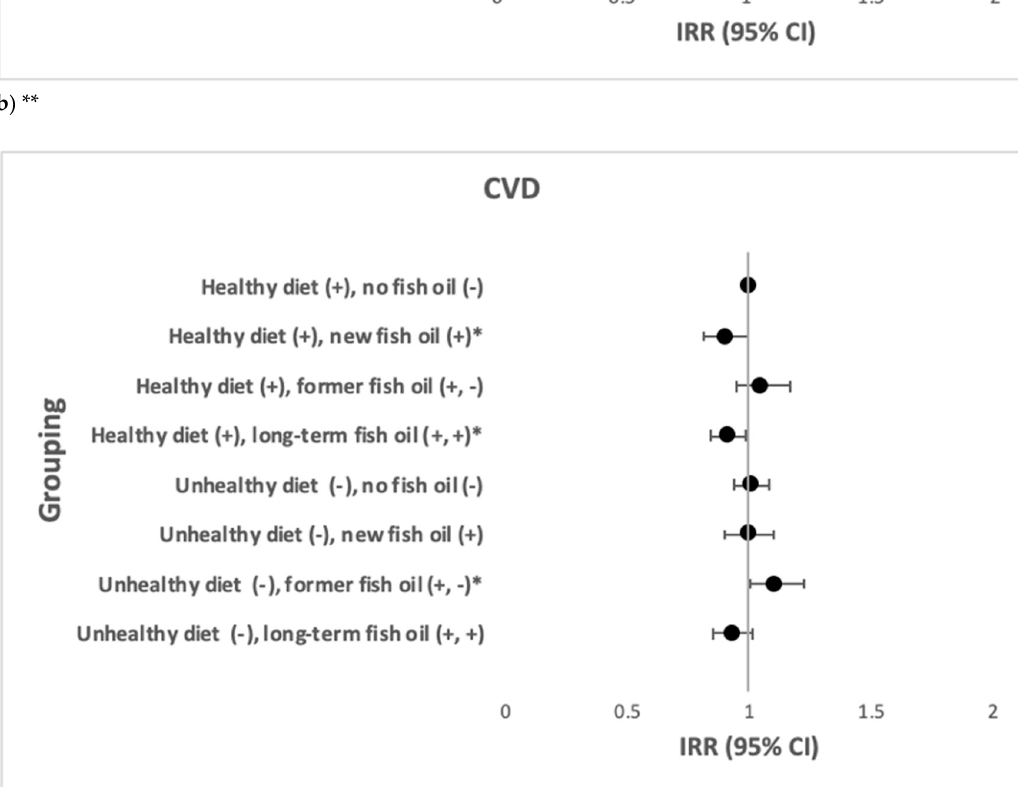
Figure 4. The joint effects of healthy vs. unhealthy diet and fish oil consumption in relation to the incidence of obesity and CVD (N = 69,990). ( a ) The joint effects of healthy vs. unhealthy diet and fish oil consumption in relation to the incidence of obesity. ( b ) The joint effects of healthy vs. unhealthy diet and fish oil consumption in relation to the incidence of CVD. * IRR after adjustment of age, gender, country of birth, marital status, education, SEIFA, smoking, physical activity, CVD, diabetes, blood cholesterol and blood pressure. ** IRR after adjustment of age, gender, country of birth, marital status, education, SEIFA, smoking, physical activity, obesity, diabetes, blood cholesterol and blood pressure.